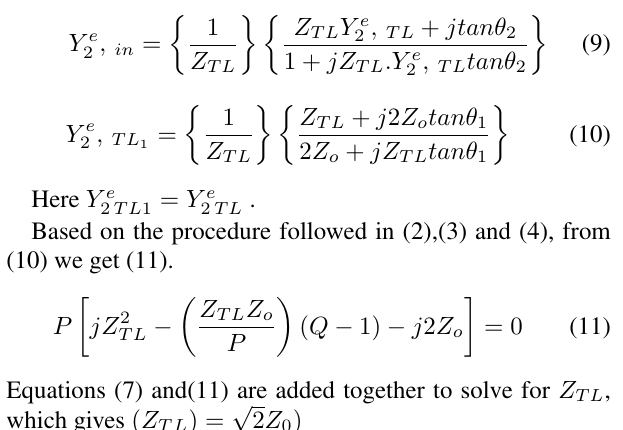
FIGURE 2. Admittance representation w.r.t. input and output ports (a). Even mode (b). Odd Mode TABLE 1. Design parameters and